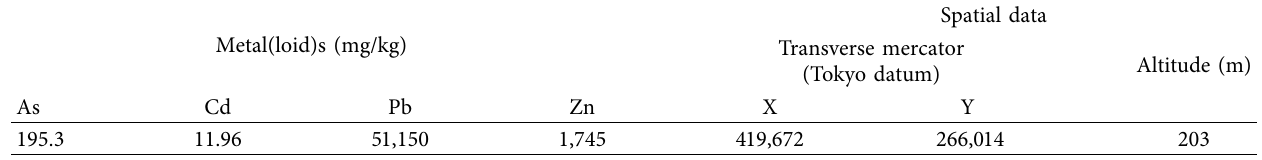
Table 2: Total concentrations of metal(loid)s in the mine tailing soil and the corresponding spatial data. Metal(loid)s (mg/kg)